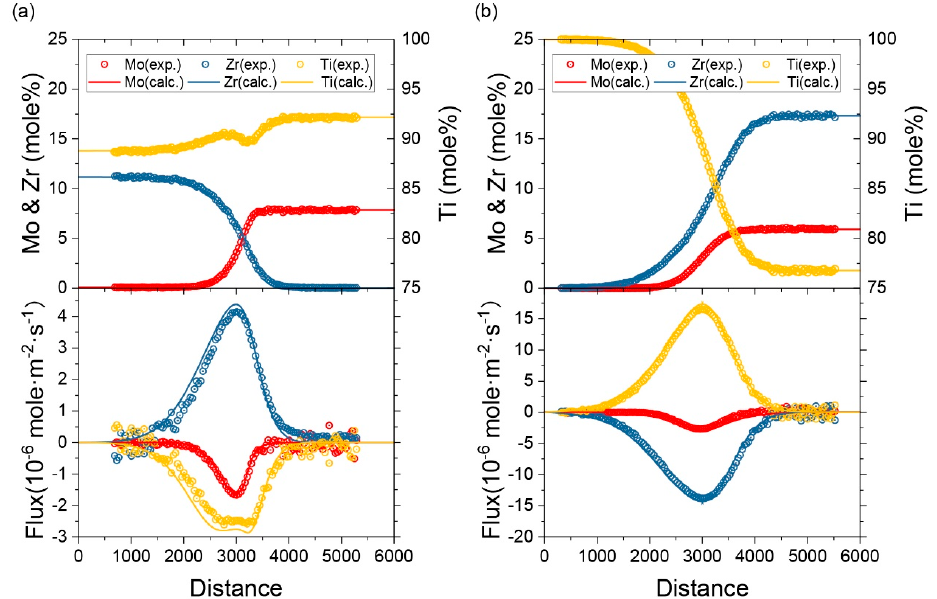
Figure 9. Predicted composition-distance profiles and inter-diffusion fluxes of M3 and N8 as compared with experimental data.